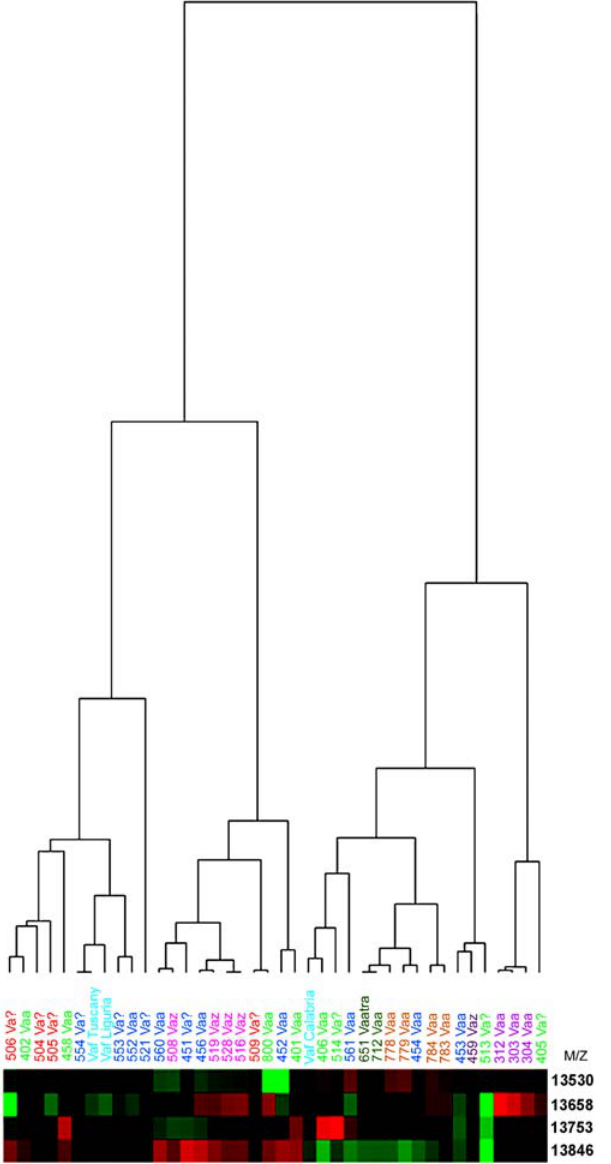
Figure 12. Heatmap obtained with clusters with p-values , 0.05. Each column in the heatmap corresponds to a spectrum, each row to a cluster (or a potential biomarker), and each cell to a peak, with the colour indicating intensity of expression (green: low expression, red: high expression). Related spectra are sorted and grouped according to similarity, resulting in the dendrogram. The length of a branch is inversely proportional to the relatedness of the spectra. Average normalised mass (m/z) of the 4 clusters with p-values , 0.05 are indicated on the right of the heatmap.